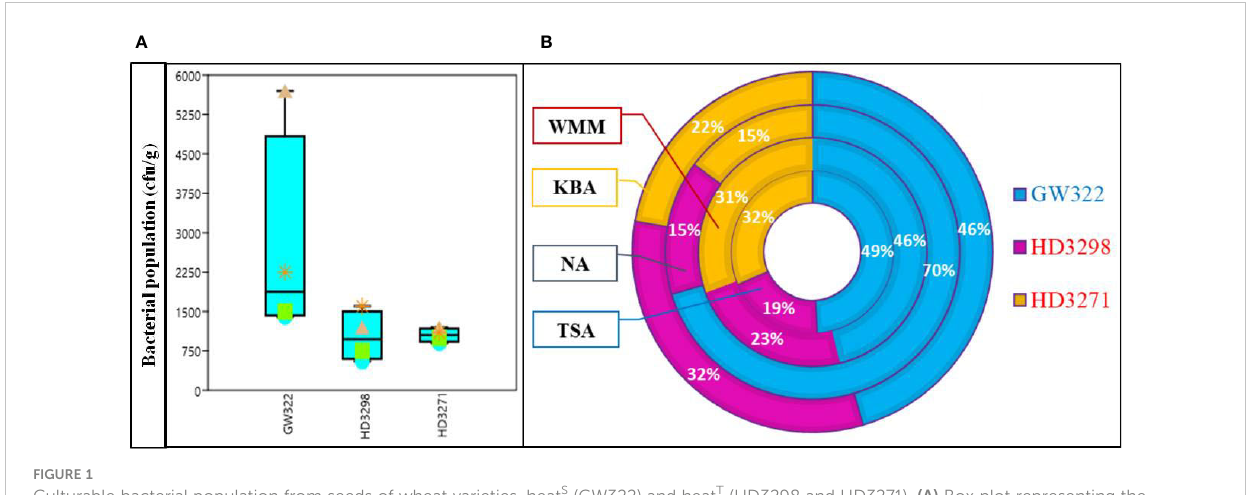
FIGURE 1 Culturable bacterial population from seeds of wheat varieties, heat S (GW322) and heat T (HD3298 and HD3271). (A) Box plot representing the population of bacteria (cfu g – 1 ) in different media. *Triangle — NA, star — KBA, square — WMM, circle — TSA. (B) Percentage of the bacterial population in